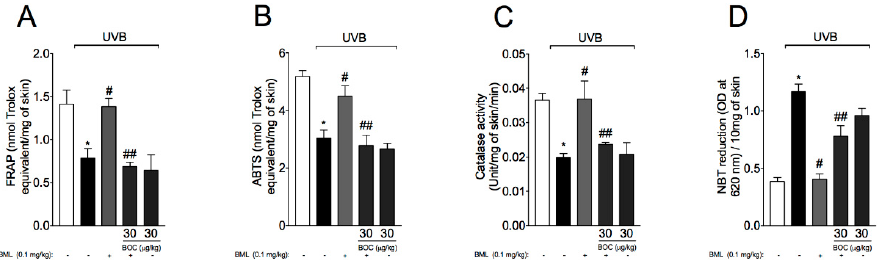
Figure 7. UVB-induced antioxidant capacity is restored by BML-111. Total antioxidant capacity (FRAP ( A ), ABTS ( B )) were determined in samples dissected 12 h after the radiation. For the catalase assay ( C ) and nitroblue tetrazolium (NBT) assay ( D ) samples were dissected 2 h after radiation.